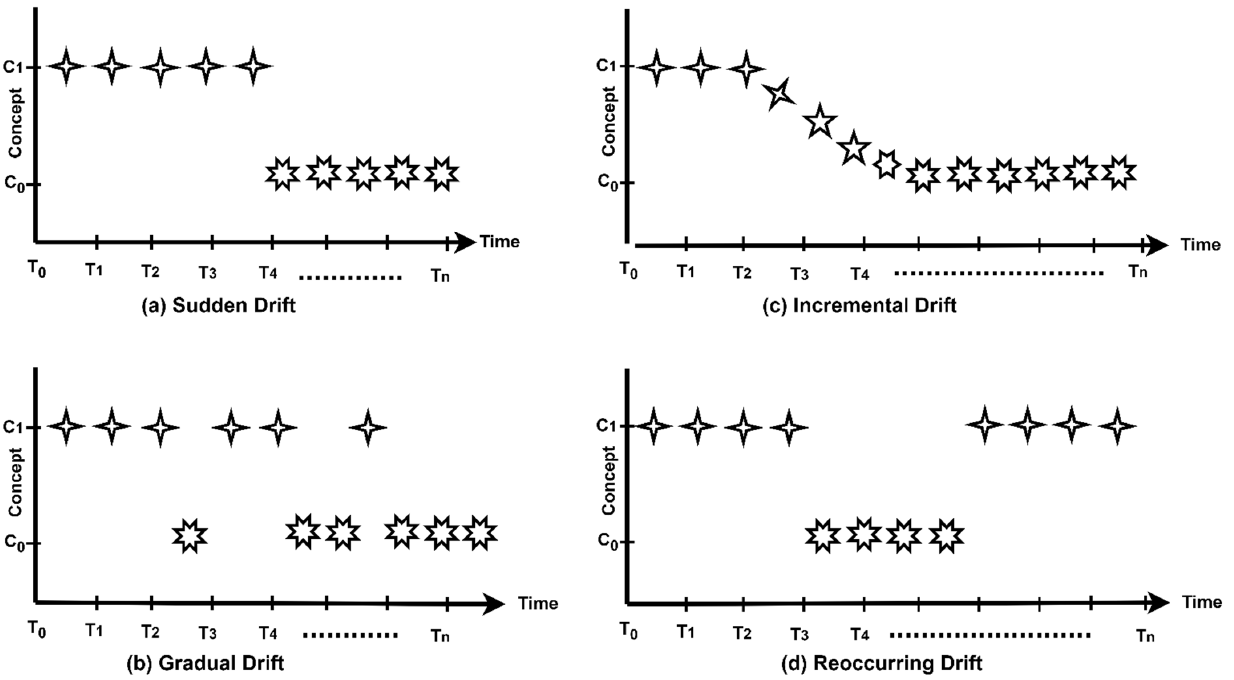
Figure 1. Types of concept drift based on time [17,18].